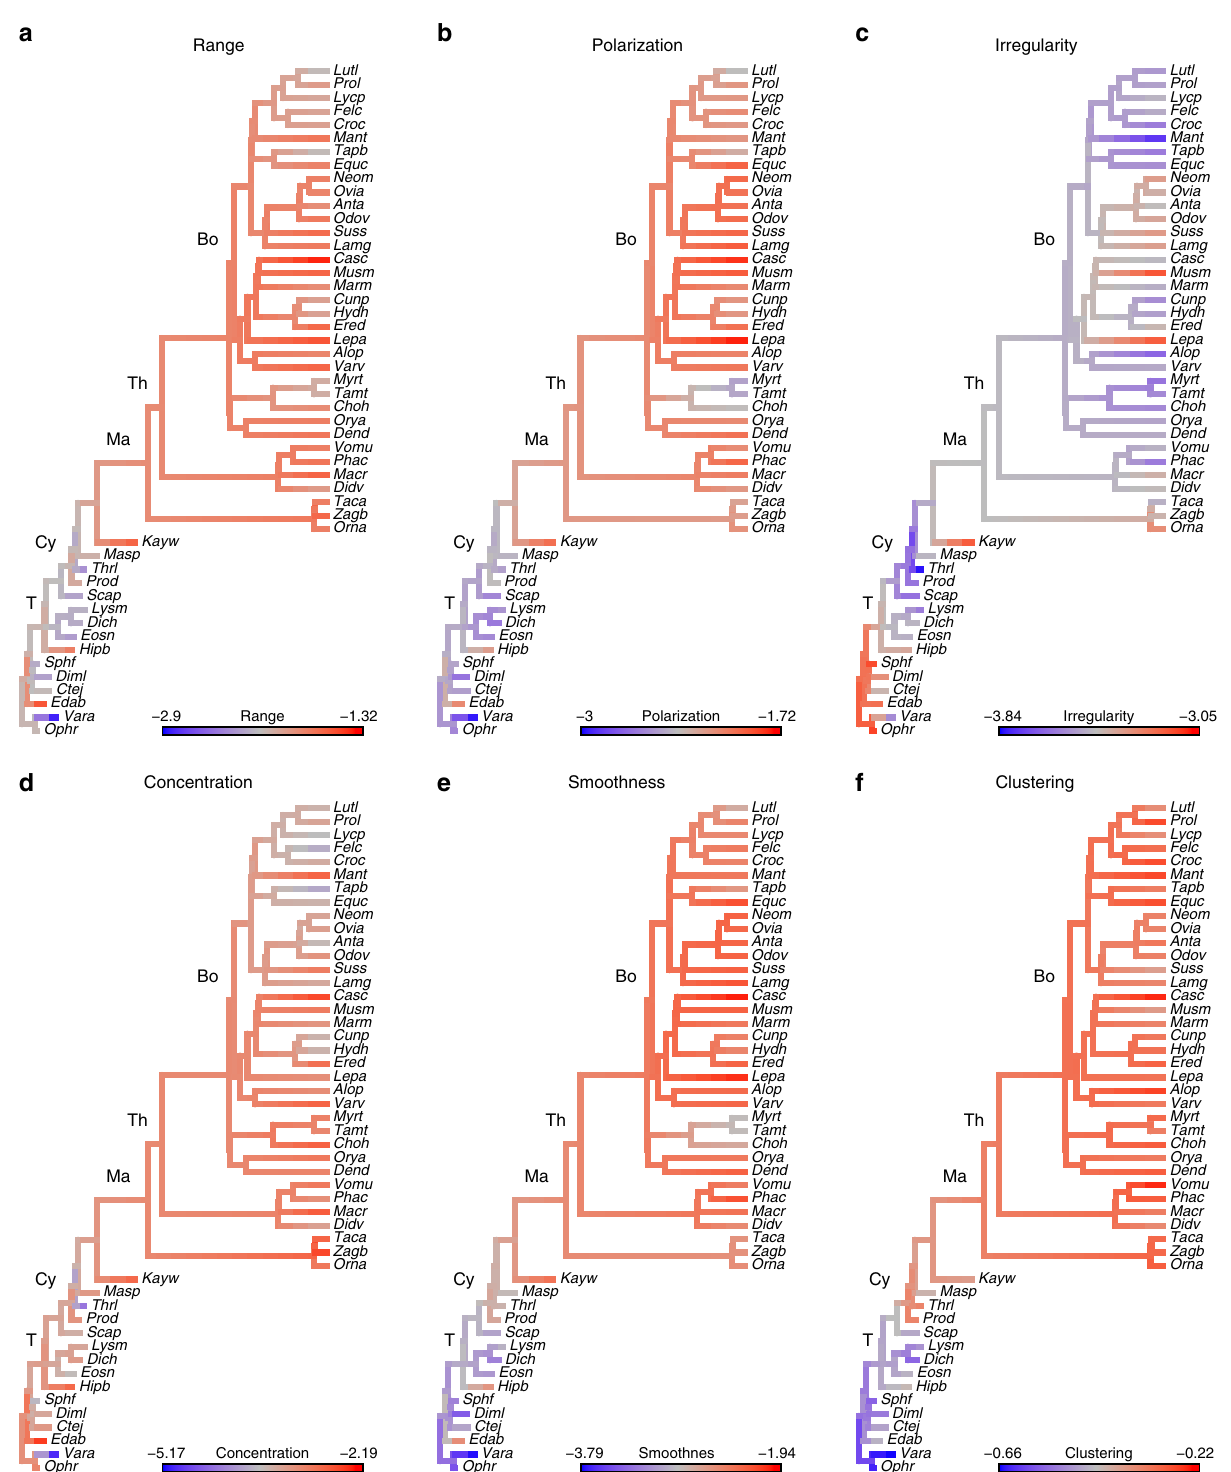
Fig. 3 Variation in vertebral complexity and organization. Based on the whole vertebra dataset optimized onto the sampled synapsid phylogeny using maximum likelihood. Evolutionary patterns of complexity: Range ( a ), Polarization ( b ), Irregularity ( c ). Evolutionary patterns of organization: Concentration ( d ), Smoothness ( e ), Clustering ( f ). For abbreviations see Supplementary Table 7. T, Therapsida; Cy, Cynodontia; Ma, Mammalia; Th, Theria;